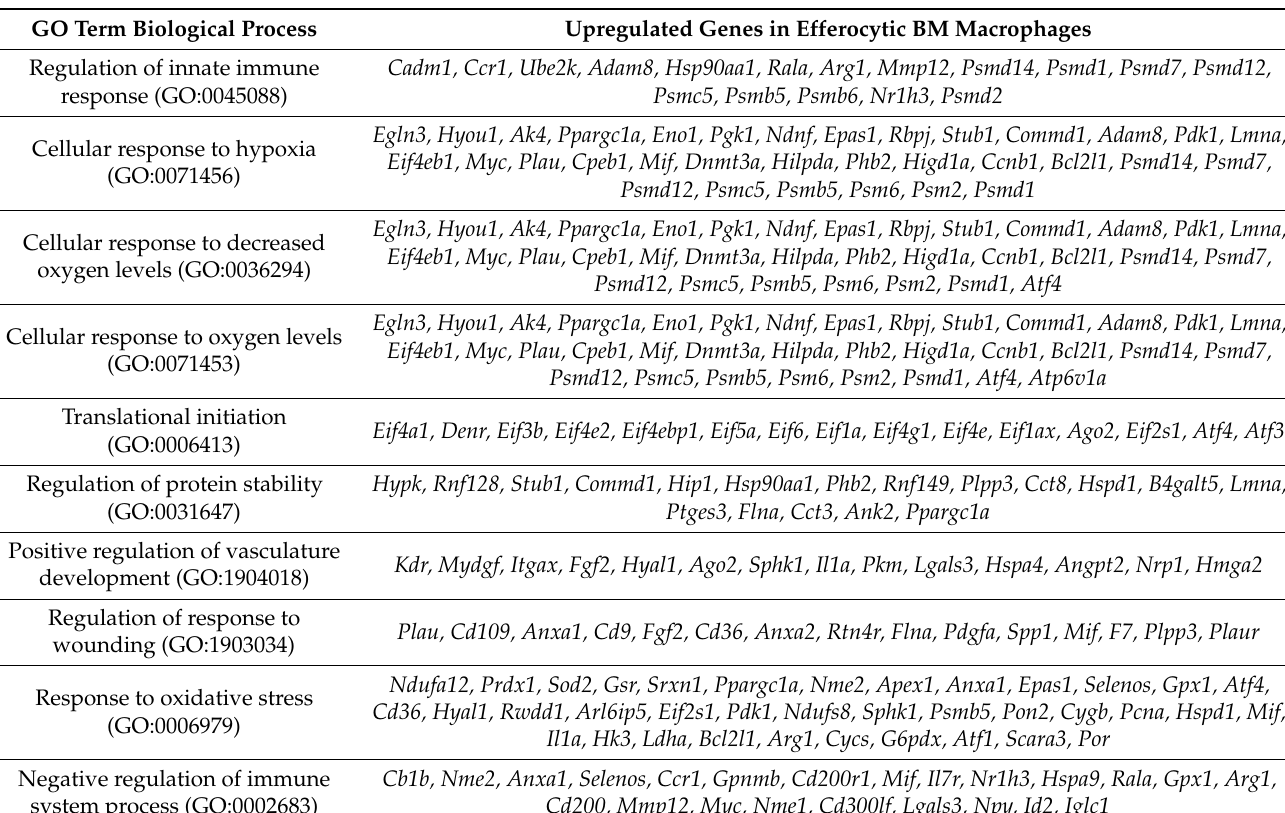
Table A3. List of upregulated genes from GO terms shown in Figure 1E and Table